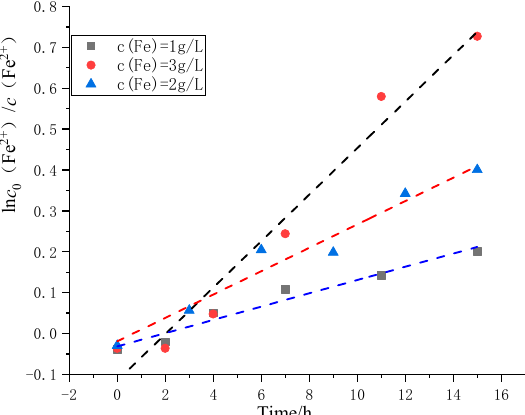
Figure 10. First-order kinetics fitting of ferrous oxidation reaction.